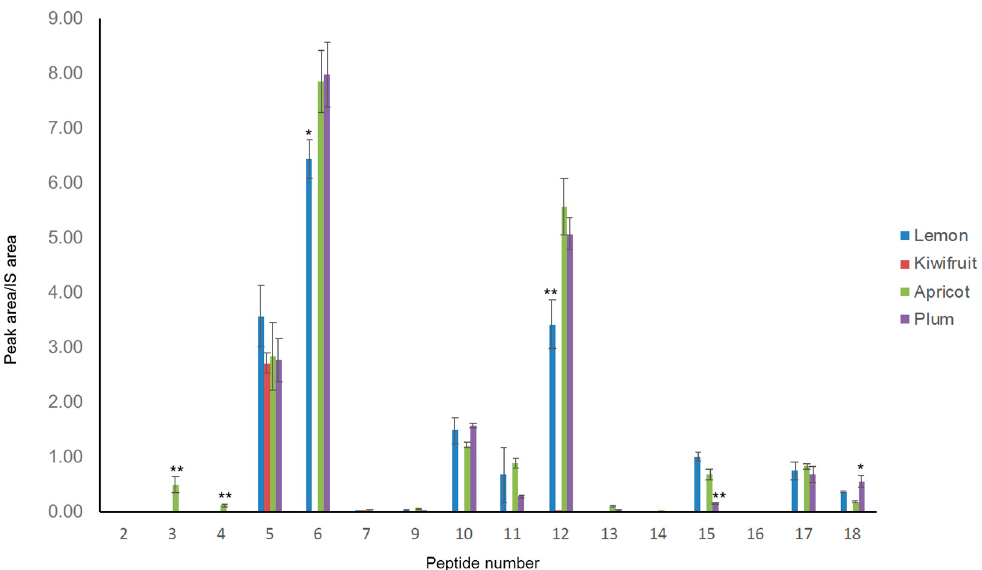
Figure 5. Area measured for peaks of the marker peptides in the LC-MS/MS analysis of four different Spirulina-enriched sorbets (lemon, kiwifruit, apricot and plum). Measurements were performed in triplicate on two different samples ( n = 6): the graphs report the average areas and standard deviations. * p ≤ 0.05 and ** p ≤ 0.01 indicate a significant difference between that peptide abundance and the same peptide in the other three samples.